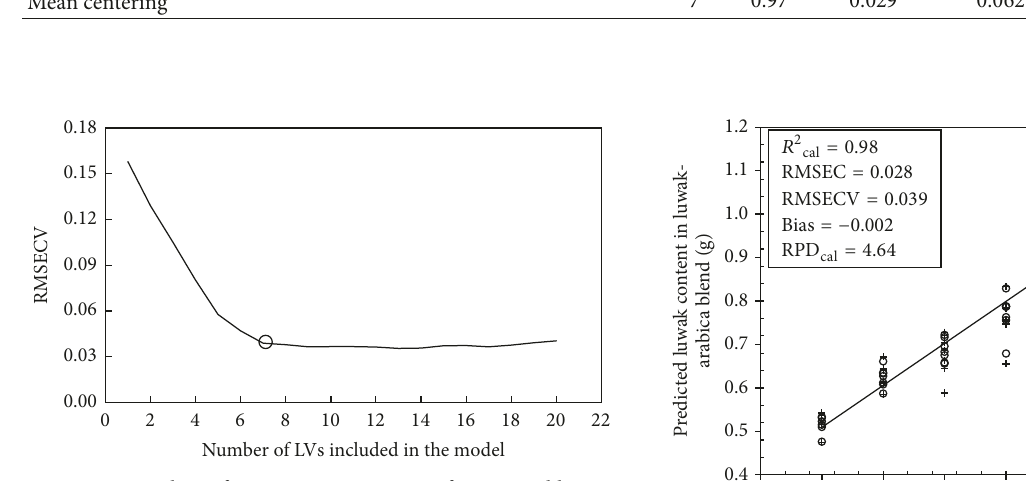
Figure 2: Number of LVs versus RMSECV for PLS calibration model for determination of luwak content.